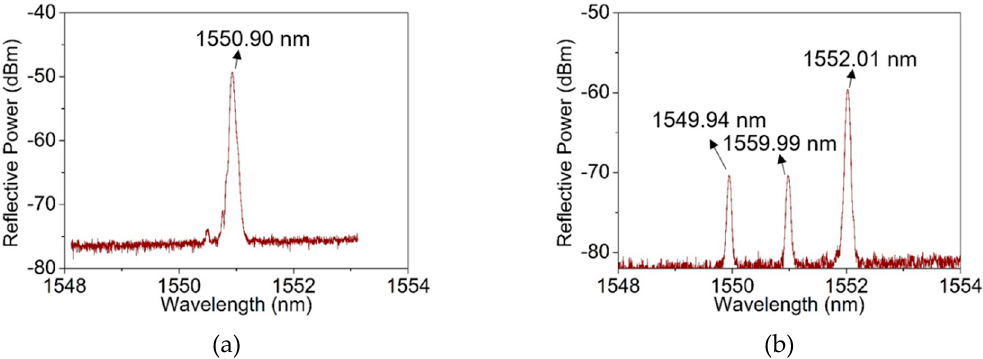
Figure 5. The experimental reflection spectrum of the FBG with the diameter of the fiber is ( a ) 125 μ m and ( b ) 200 μ m, the inset is the experimental optical field distribution.